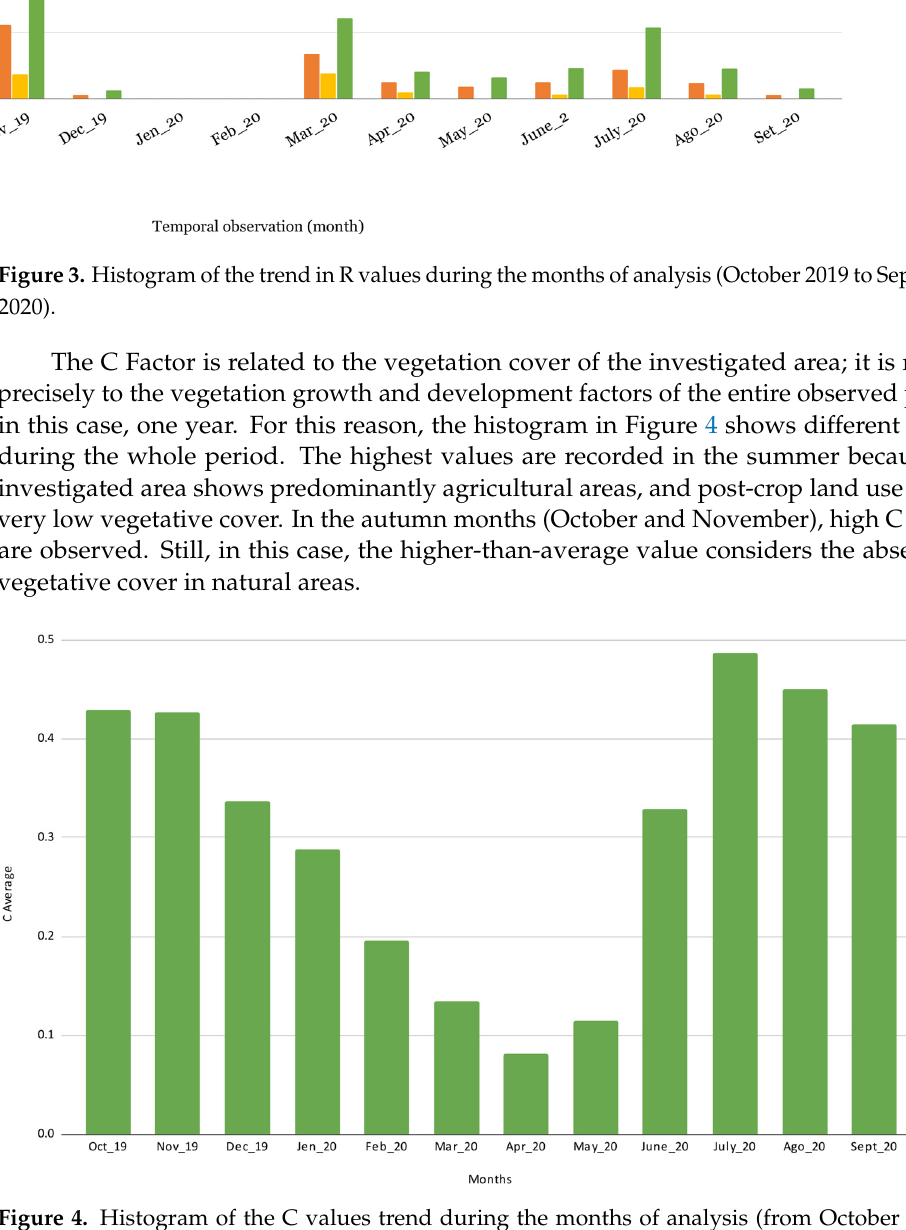
Figure 3. Histogram of the trend in R values during the months of analysis (October 2019 to